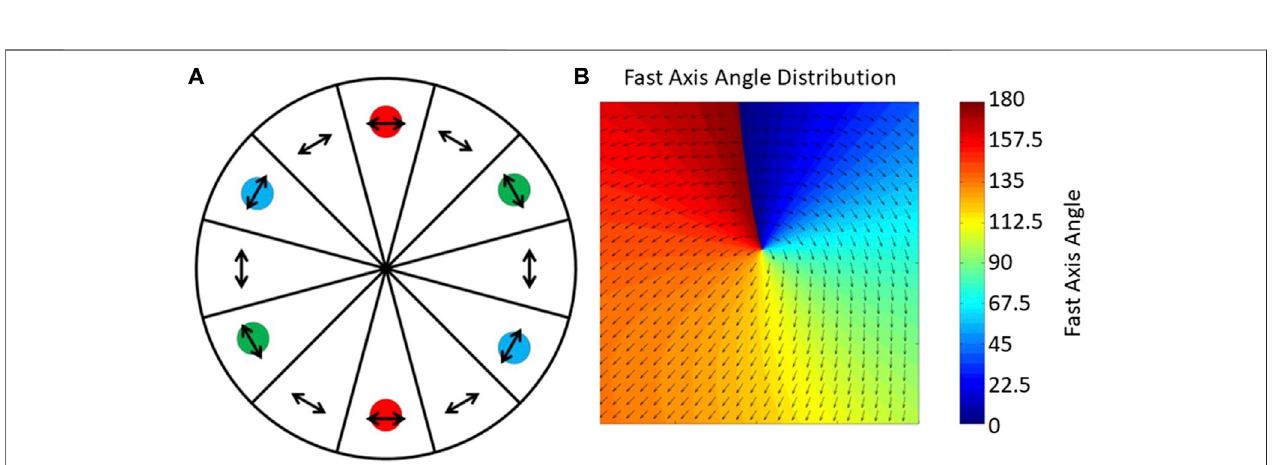
FIGURE 4 | Unique approaches to improving polarization control. (A) , The pizza polarizer. The arrows indicate the direction of the transmission axis of each polarizer and the color circles indicate the position of ± 1-order diffraction beams on the pizza polarizer [37]. The fi gure is modi fi ed with permission from Ref. (37). Copyright © 2015 IOPPublishing. (B) ,The zero-order vortex half-wave retarderis anon-uniform half-wave plate whose fast axis distributes in the direction ofthe arrows shown [39].